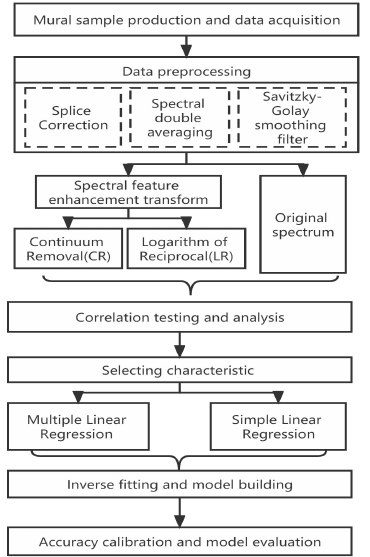
Figure 3. Overall technical flow chart